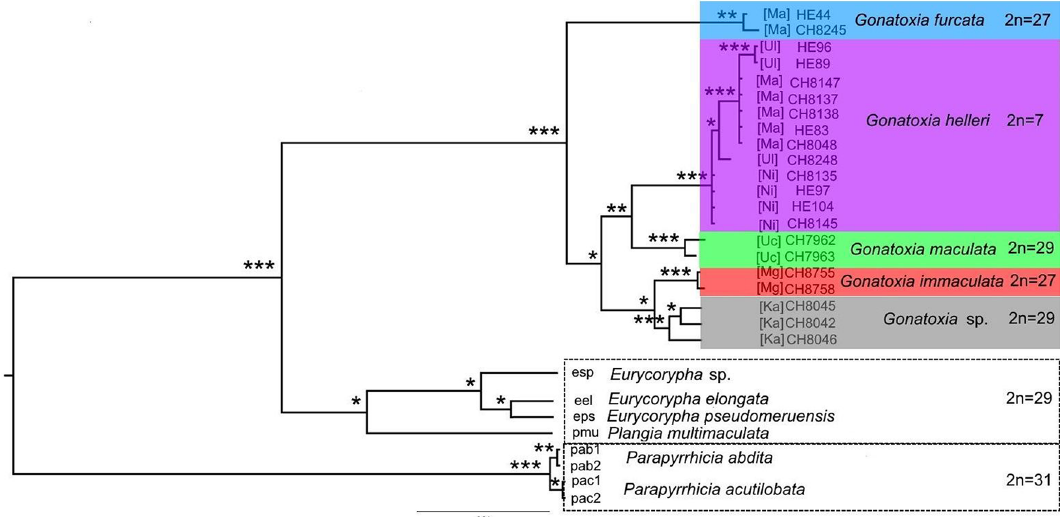
Figure 3. Phylogenetic reconstruction of Gonatoxia based on COI sequences with Eurycorypha, Parapyrrhicia and Plangia . Posterior probability/bootstrap values are indicated by *** = 1/100%, ** = 0.99–0.95/99–95% and * ≤ 0.94/94% (above branches). Diploid chromosome numbers for species are plotted on the tree. Acronyms at the tip labels are meant geographic areas: [Ma]—Udzungwa Mountains, Mangula Gate, [Ul]—Uluguru Mts, [Ni]—Nilo forest reserve, [Uc]—Mt. Kilimanjaro, Uchira, [Mg]—East Usambara Mountains, Magoroto Forest Estate, [Ka]—Kazimzumbwi Forest Reserve. Clades within Gonatoxia are indicated by colours corresponding to localities in Fig. 1. Scale bar: number of substitutions per nucleotide